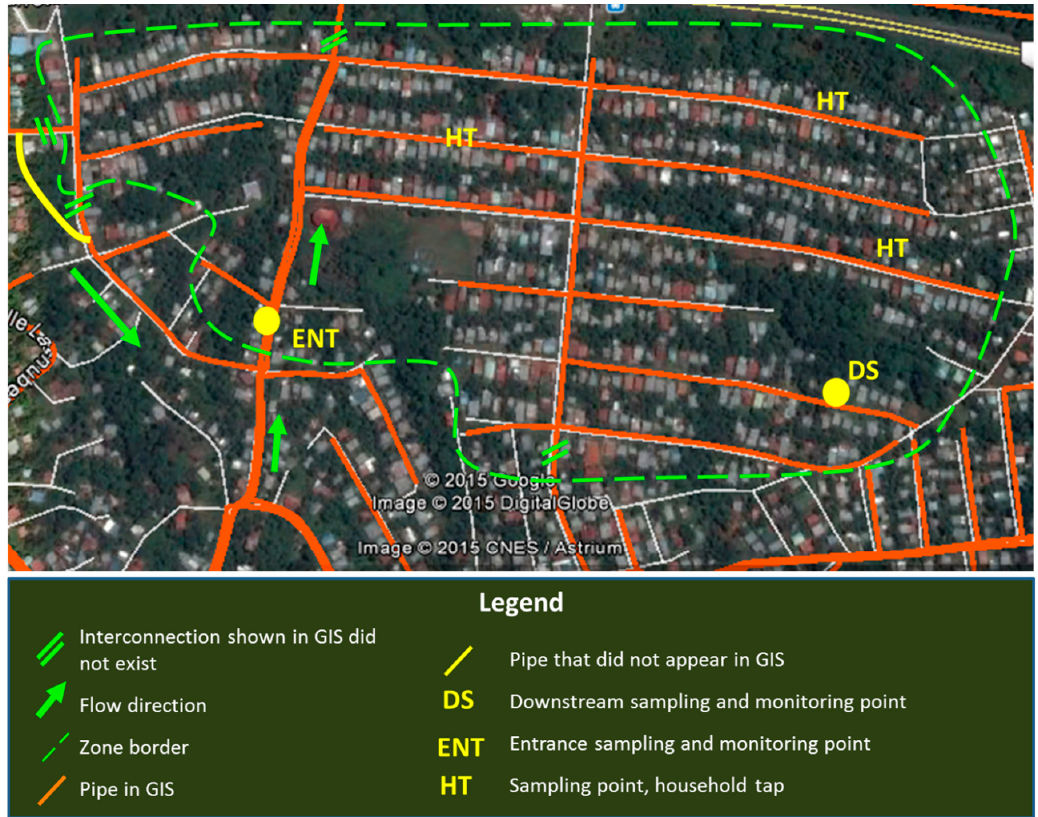
Figure 2. Schematic of Study Zone 2. The entrance (ENT) and downstream (DS) locations at which continuous monitoring stations were installed are indicated, as well as the household taps at which water quality grab samples were collected. (Source of satellite images and study zone schematic: Google Earth and IDAAN’s GIS database).